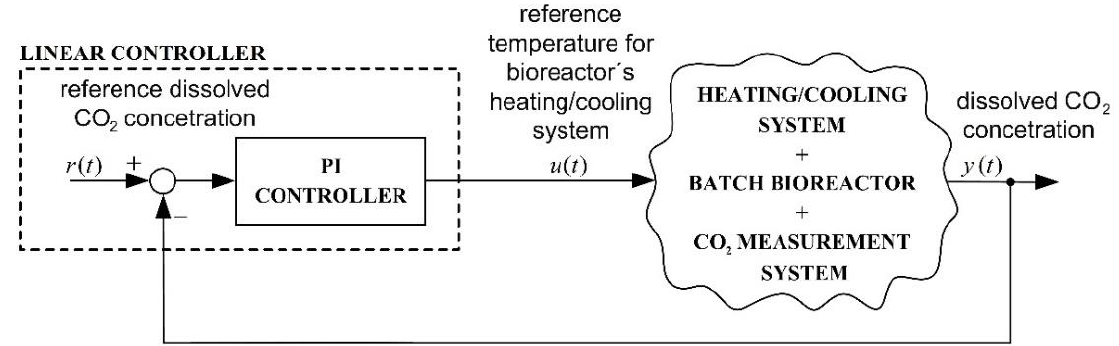
Figure 2. Block diagram of the conventional control system with linear controller.